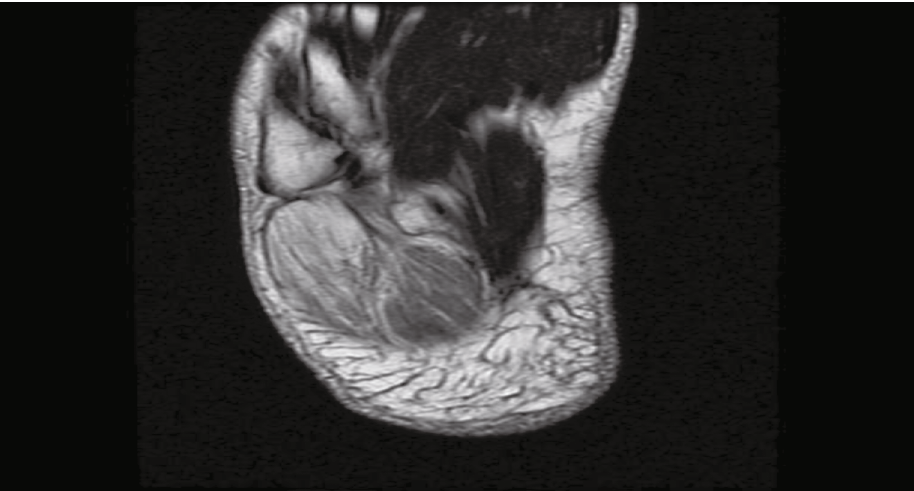
Figure 4: Axial T2 showing abnormally high T2 signal intensity along the muscle fi bers with involvement of the adjacent muscle ( fl exor digitorum